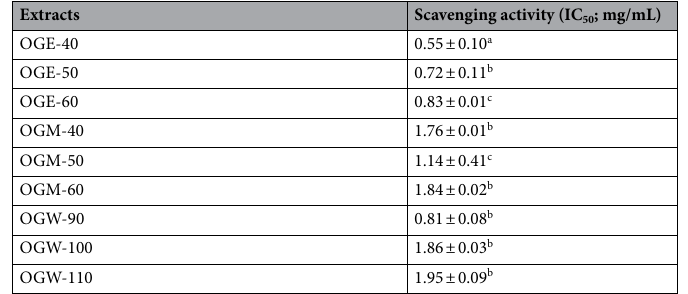
Table 5. Half-maximal concentration (IC 50 ) values for the DPPH free radical-scavenging activity assay of O. gratissimum extracts. Values shown are means of three replicates (n = 3) ± SD. Values with different superscript letters (a–c) within each column are significantly different ( P ≤